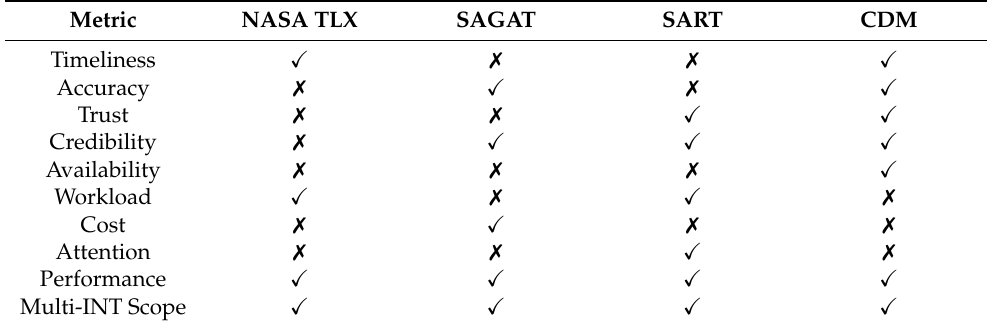
Table 1. Comparison of SA assessment